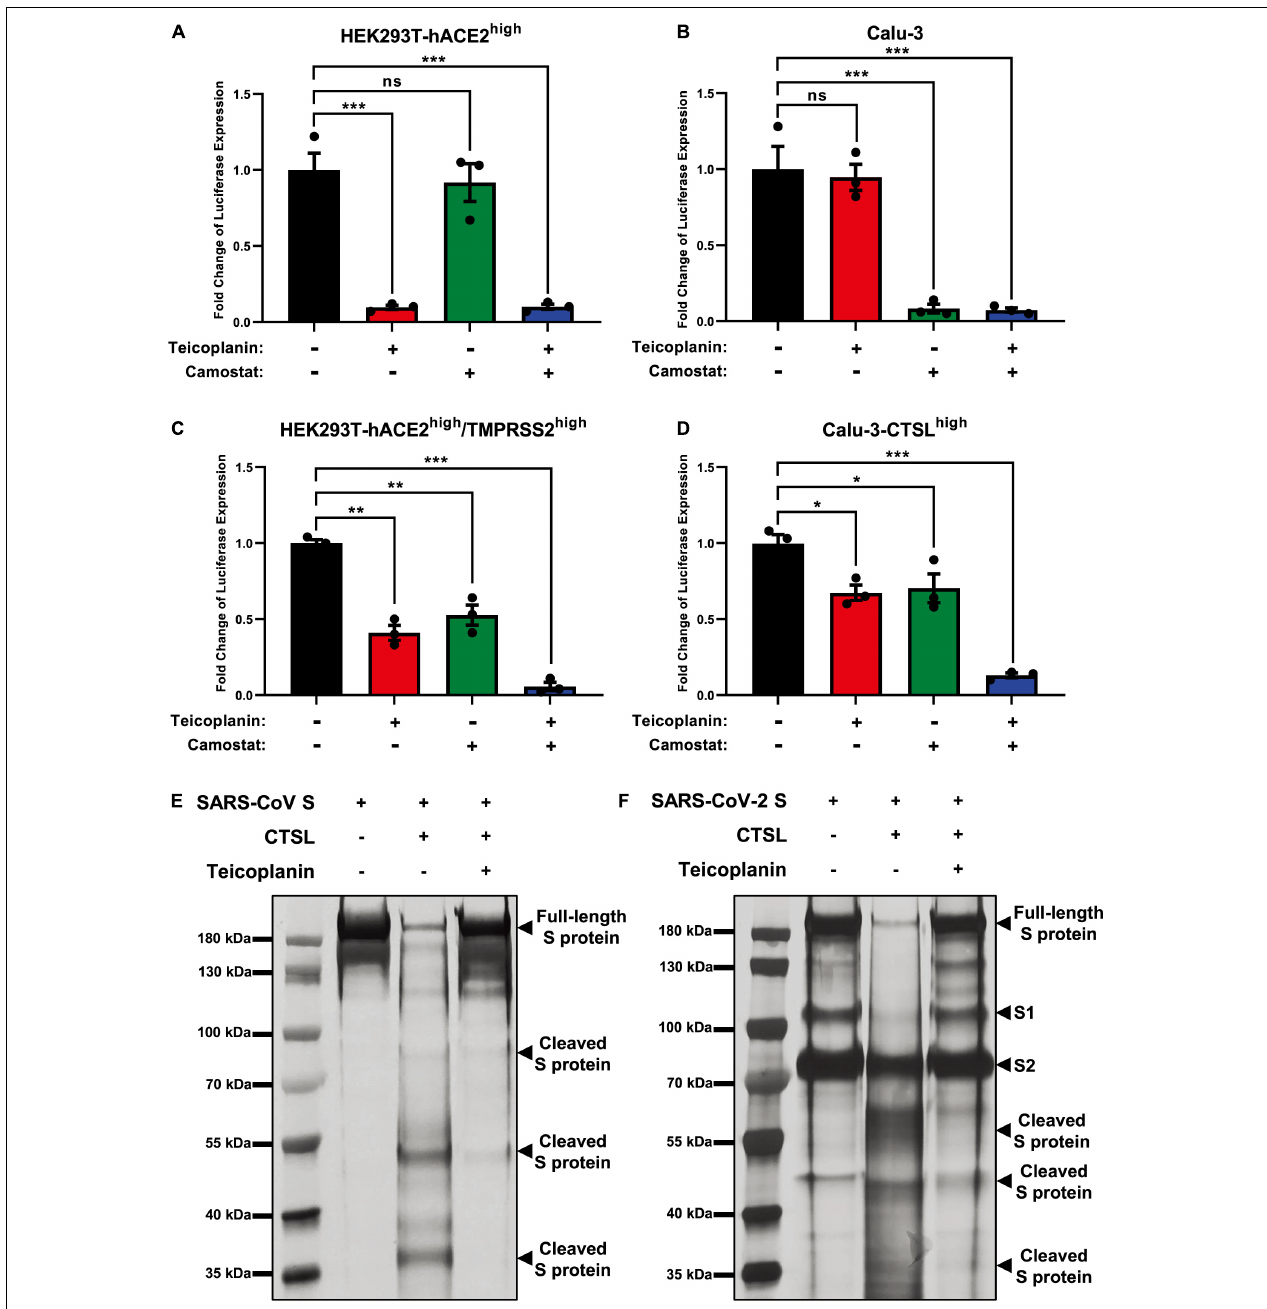
FIGURE 4 | Teicoplanin inhibited the activity of CTSL. (A) HEK293T-hACE2 high cells were incubated with 25 µ M teicoplanin or 50 µ M camostat, followed by infecting with pseudotyped SARS-CoV-2 S/HIV-1 virus. The expression of luciferase was evaluated 48 h post infection ( n = 3). (B) Calu-3 cells were incubated with 25 µ M teicoplanin or 50 µ M camostat, followed by infecting with pseudotyped SARS-CoV-2 S/HIV-1 virus. The fold change of luciferase expression was calculated as in (A) ( n = 3). (C) HEK293T-hACE2 high cells were transfected with TMPRSS2-expressing plasmids to construct the HEK293T-ACE2 high /TMPRSS2 high cell line. These cells were treated with 25 µ M teicoplanin or 50 µ M camostat, followed by infecting with pseudotyped SARS-CoV-2 S/HIV-1 virus. The fold change of luciferase expression was calculated as in (A) ( n = 3). (D) Calu-3 cells were transfected with CTSL-expressing plasmids to construct the Calu-3-CTSL high cell line. These cells were treated with 25 µ M teicoplanin or 50 µ M camostat, followed by infection with pseudotyped SARS-CoV-2 S/HIV-1 virus. The fold change of luciferase expression was calculated as in (A) ( n = 3). (E,F) The in vitro purified 250 ng CTSL proteins were added into CTSL assay buffer for activation. In another group, CTSL were co-incubated with 50 µ M teicoplanin. After activation, the in vitro purified SARS-CoV S or SARS-CoV-2 S proteins were added into each group. S protein only group was set as control group. The digested proteins were proceeded to SDS-PAGE and analyzed by silver staining. Data in (A,D) represented as mean ± SEM in triplicate. P -values were calculated by one-way ANOVA with Dunnett’s multiple comparison test which compared the mean of each group with the mean of the control group. ns p ≥ 0.05, * p < 0.05, ** p < 0.01, *** p < 0.001.